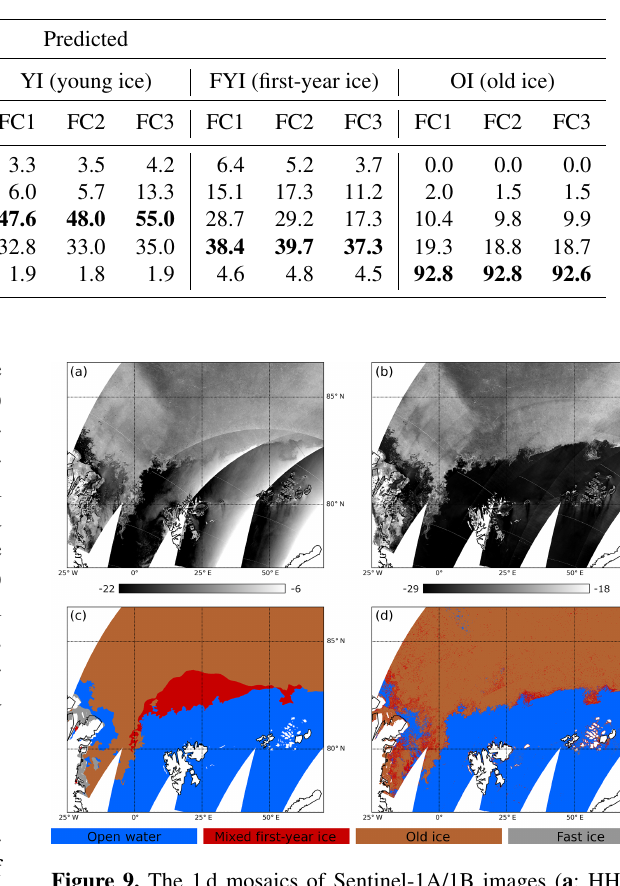
Table 4. Confusion matrix of the five-class RF classifier which was trained with the DS1 winter dataset and applied to the DS2 winter dataset. The bold font indicates where the classification was done correctly.